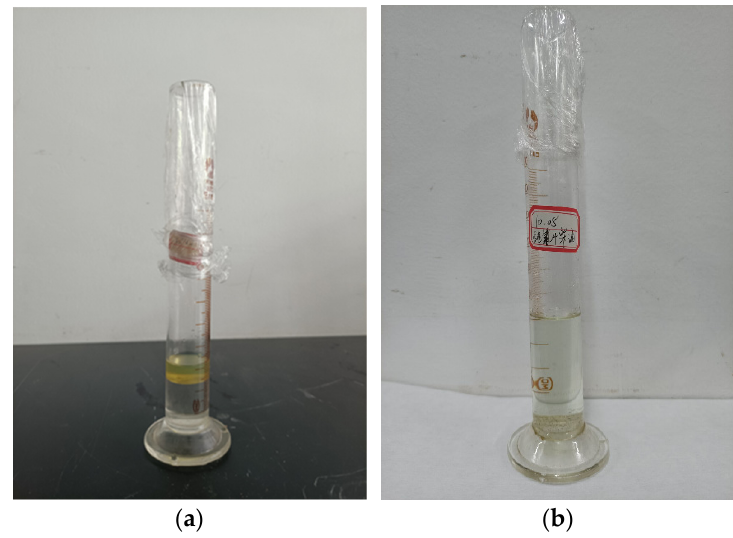
Figure A4. One-dimensional sand pack.